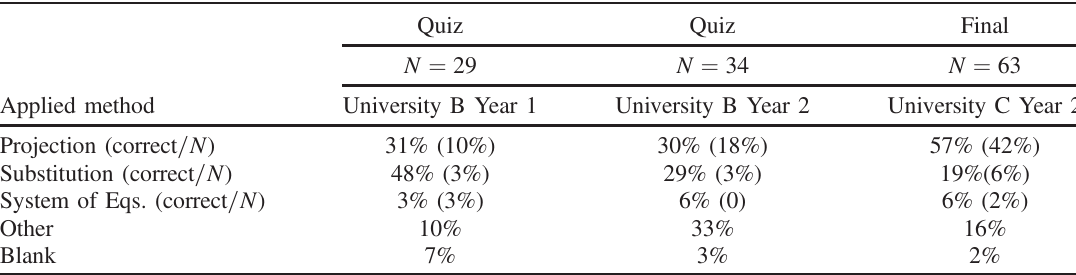
TABLE II. A list of the different methods students used to change basis and the frequency of each method at Universities B and C. The quiz was given at University B for credit within 2 weeks following all related instruction. For the three methods that can lead to correct answers, the number in parentheses indicates the percentage of all students who both applied the method and also arrived at the correct answer. These data were collected before any tutorial implementation.